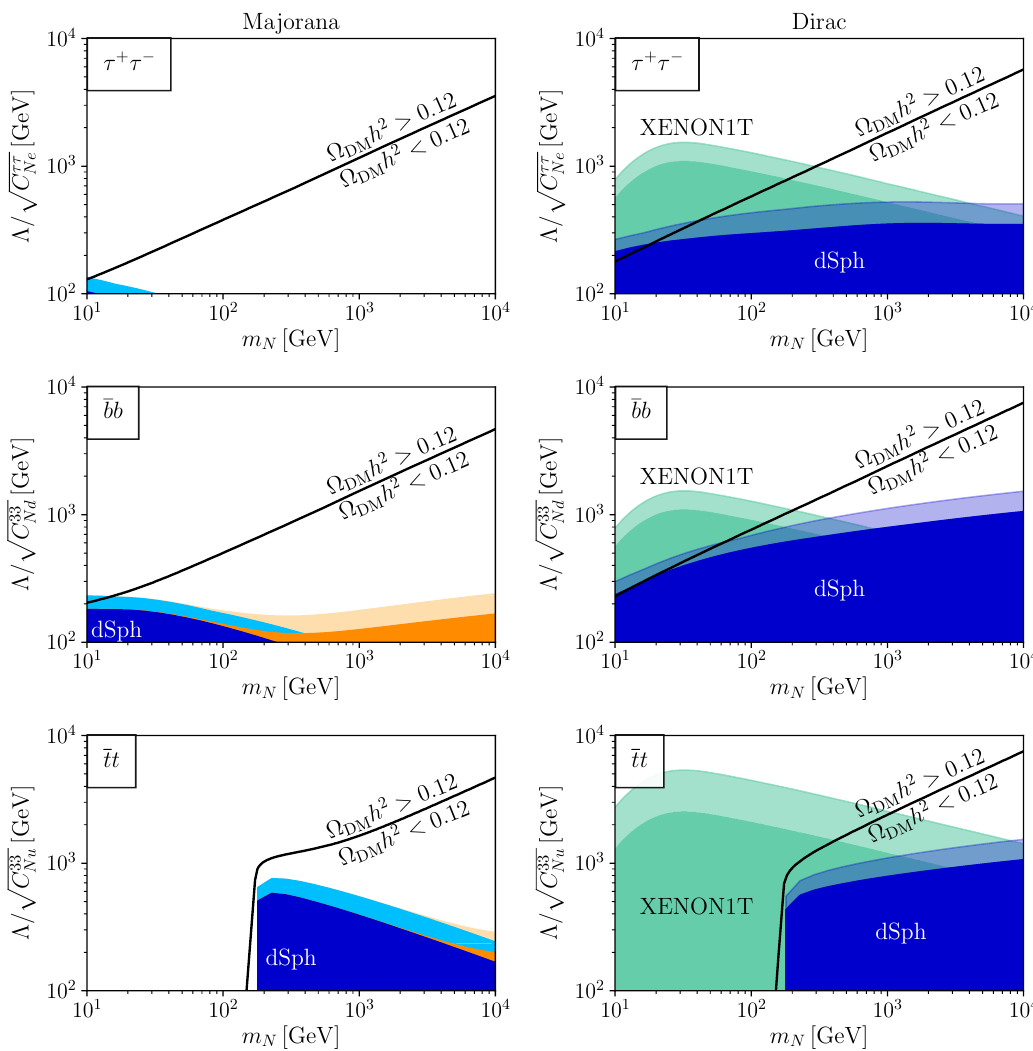
Figure 1: New physics scale required by the relic abundance for the third gener- ation EFT scenarios (black line), assuming Majorana (left) and Dirac (right) ster- ile neutrinos. Regions excluded by indirect detection from dwarf spheroidals are shown in blue. The light blue region corresponds to the variation of the J -factors within their 68% confidence bands. The orange bands show the indirect detec- tion exclusion when we include the loop-induced D7 operator, Eq.(8). Direct de- tection limits from XENON1T (extrapolated between 1 TeV and 10 TeV) assuming 100 GeV < Λ < 10 TeV are shown in teal, the weaker bounds corresponding to Λ = 100 GeV (200 GeV in the tt -case). Direct and indirect detection constraints h 2 = 0.12 assume Ω DM